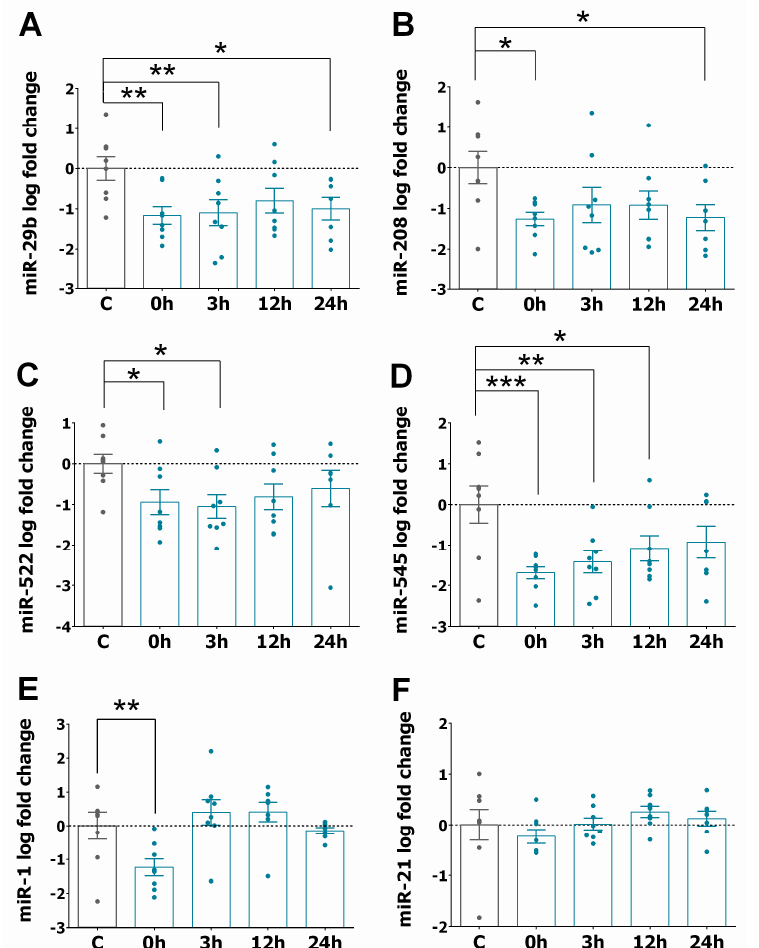
Figure 3. Downregulation of circulating miRNA levels in the serum of STEMI patients. ( A–F ) Graphs represent miRNA expression in the serum of STEMI patients ( n = 8) compared to the control ( n = 8) before PPCI (0 h) and 3, 12, and 24 h. Bar graphs show the expression of miR-29b ( A ), miR-208 ( B ), miR-522 ( C ), miR-545 ( D ), miR-1 ( E ) and miR-21 ( F ) in patients compared to control patients. Values are presented as the means ± SEM and represent the fold change in logarithmic scale for each miRNA relative to controls. Significance is indicated by (*) for p < 0.05, (**) for p < 0.01, and (***) for p < 0.001). Ordinary one-way ANOVA with multiples comparisons using T-test without correction (Fisher’s LSD test) was performed.